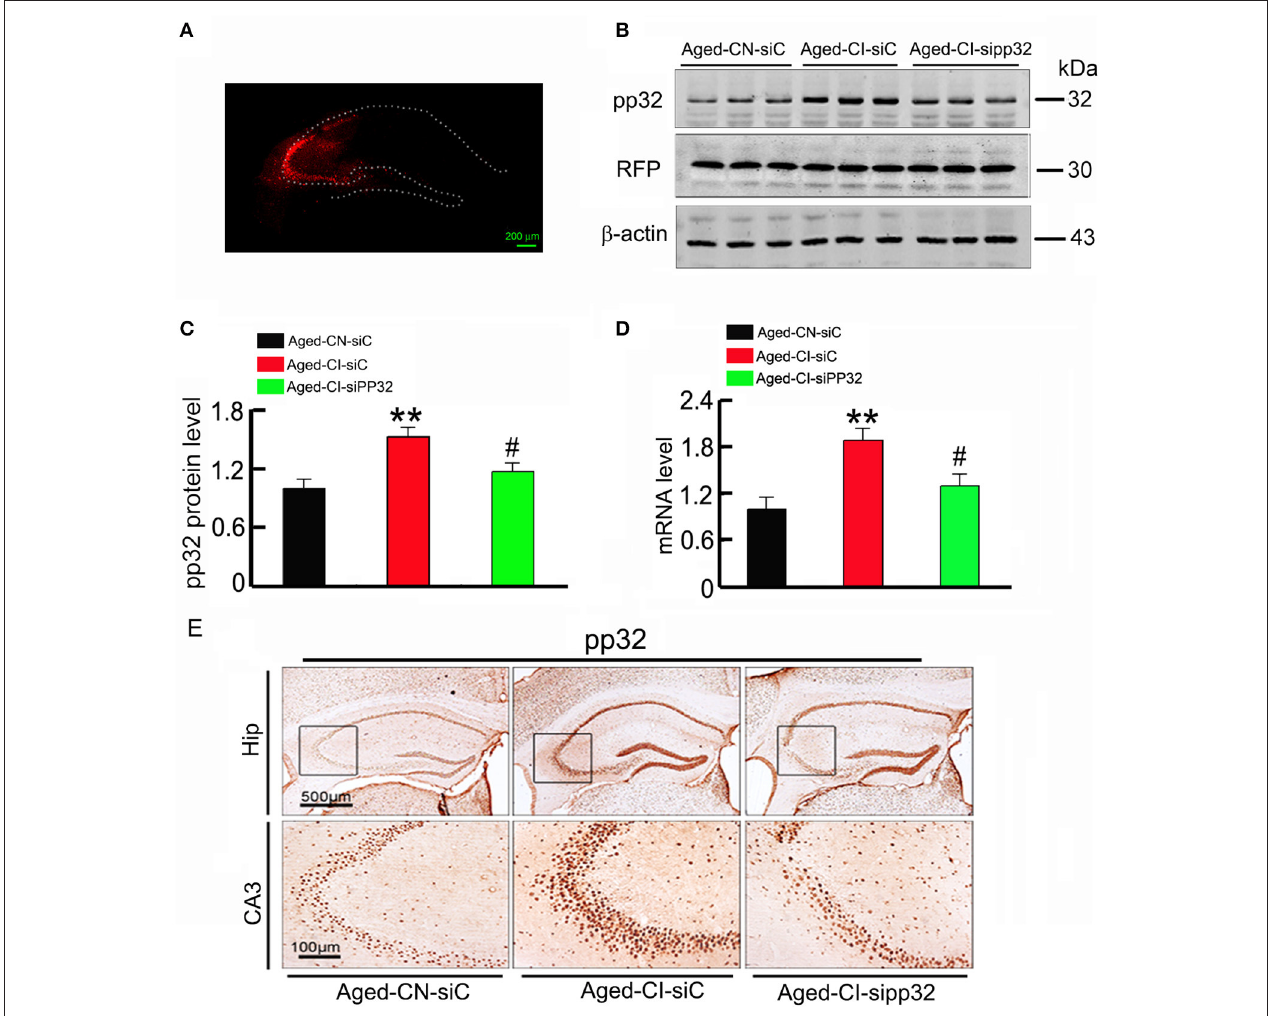
FIGURE 2 | Sipp32 decreases the protein and mRNA level of pp32 in the hippocampal CA3 region of aged cognitive-impaired mice. Lentiviruses co-expressing RFP and pp32 shRNA (sipp32) or the scrambled control shRNA (siC) (2 × 10 9 TU/ml) were stereotaxically injected into the hippocampal CA3 area of Aged-CN or Aged-CI mice (Aged-CN-siC, Aged-CI-siC, and Aged-CI-sipp32). Four weeks later, the mice were sacrificed for the following measurements. (A) Representative fluorescent images of LV-transfection in the hippocampal CA3 region of the aged mice. (B,C) . Level of pp32 protein and RFP in the hippocampal CA3 region of aged mice was detected by Western blotting and quantitative analysis. (D) Level of pp32 mRNA in the hippocampal CA3 region of aged mice was detected by RT-PCR. (E) Representative immunohistochemical images of pp32 expression in the hippocampal CA3 region of the aged mice. N = 3 for each group. ** p < 0.01 vs. Aged-CN-siC; # p < 0.05 vs. Aged-CI-siC (mean ± SD ).